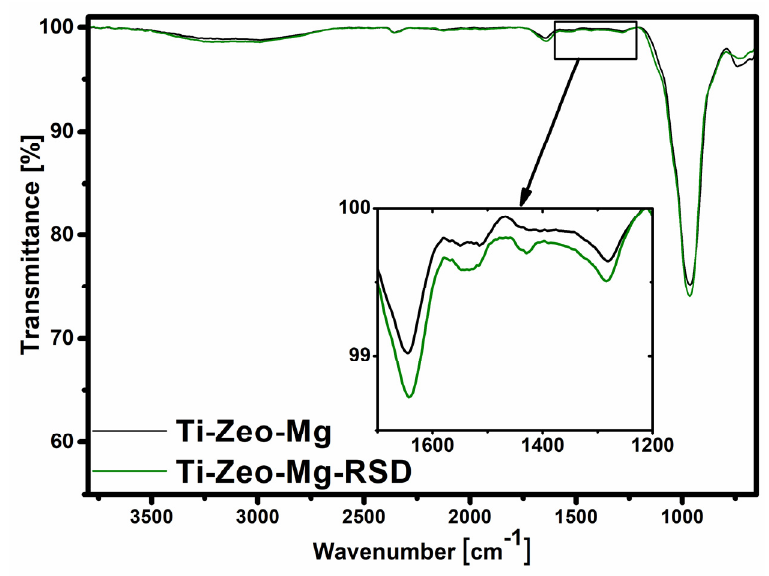
Figure 4. FTIR spectra of magnesium zeolite layers before and after drug sorption.